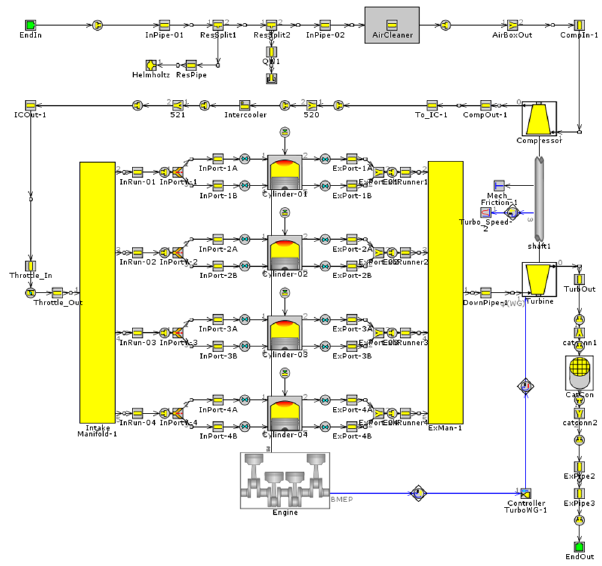
Figure 15. 1D CFD (Computational Fluid Dynamics) model of the engine.